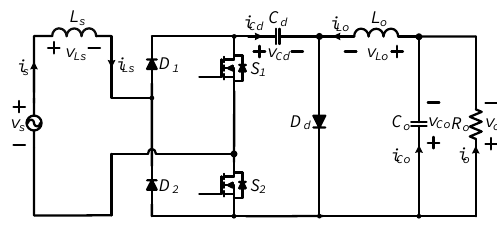
Figure 3. Bridgeless Cuk converter [19].